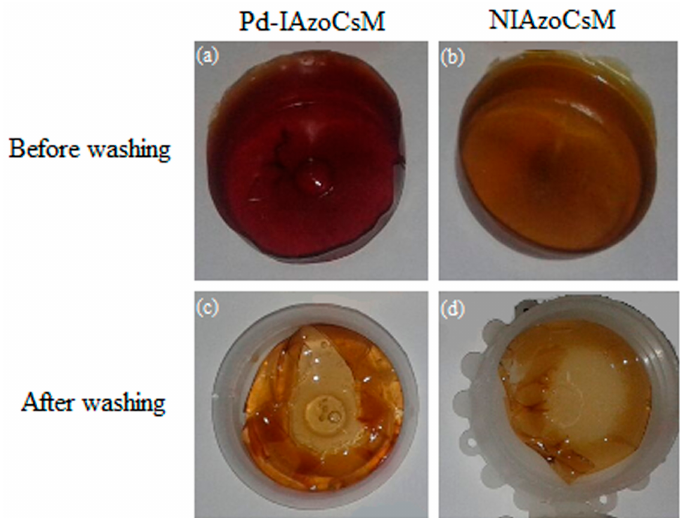
Figure 1. Photographs of the synthesized membranes ( a ) Pd(II)-imprinted, azobenzene-modified chitosan membrane (Pd-IAzoCsM) and ( b ) non-imprinted, azobenzene-modified chitosan membrane (NIAzoCsM) before washing in their dried state and ( c ) Pd-IAzoCsM and ( d ) NIAzoCsM after washing with HNO 3 0.5 M in their swollen state.